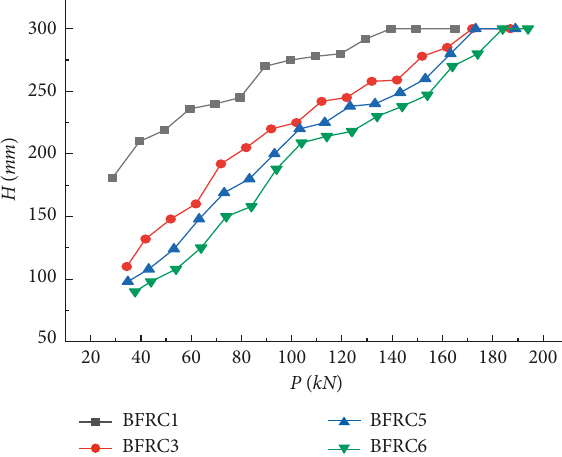
Figure 7: Load-maximum crack height curves under different volume ratios of steel fibers.